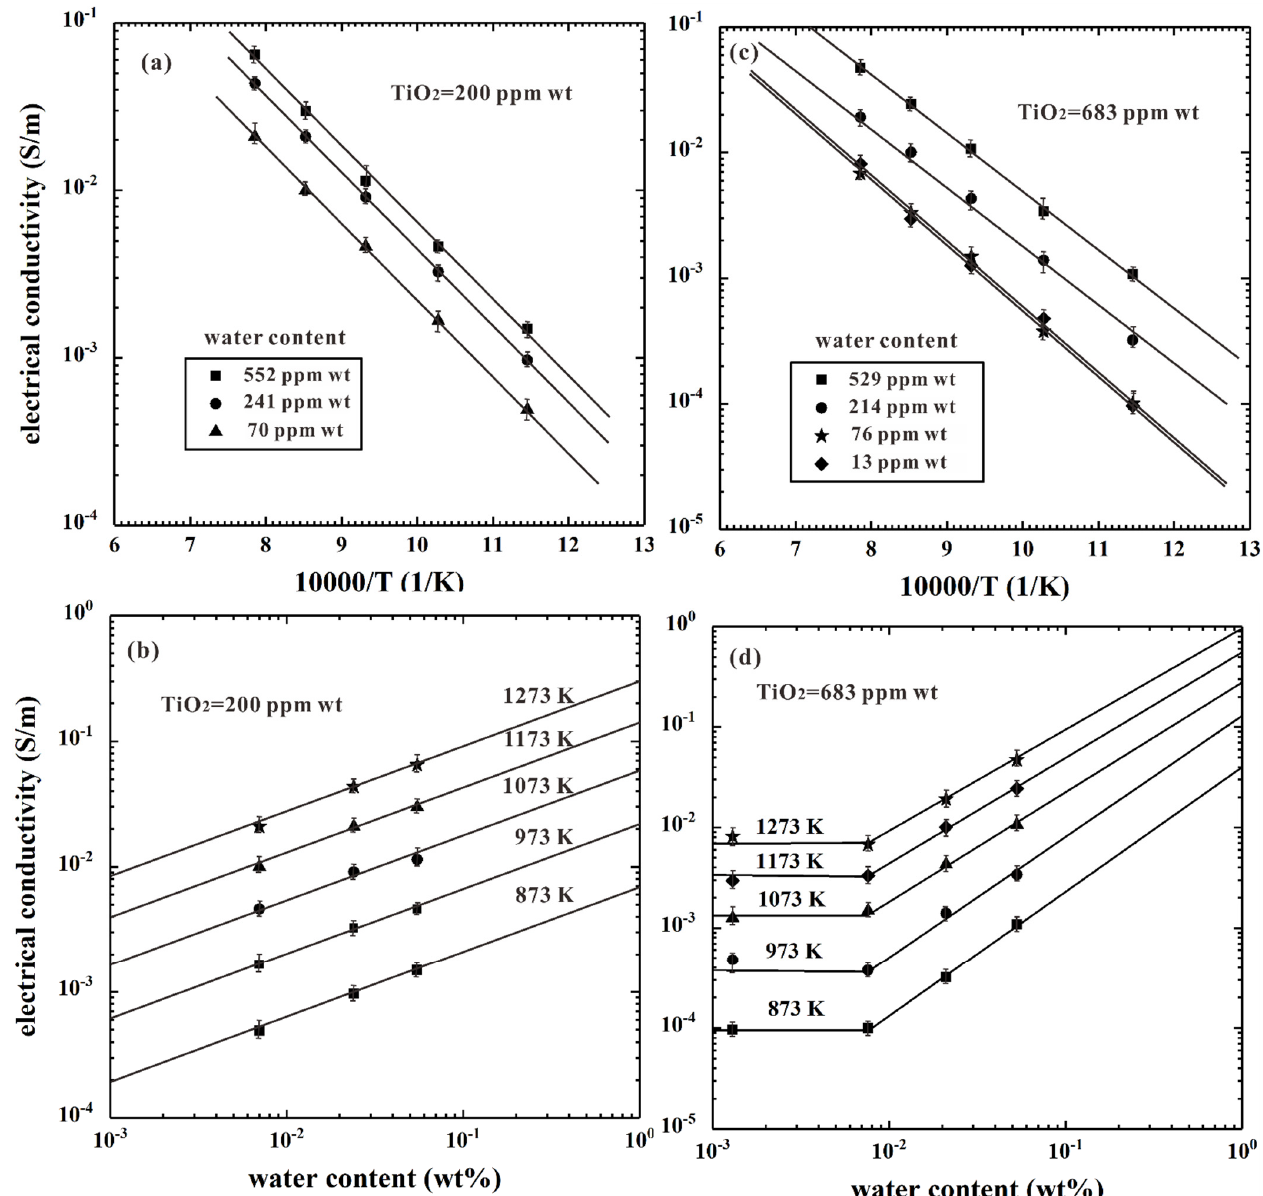
Figure 5. Electrical conductivity of hot-pressed polycrystalline olivine aggregates with different TiO 2 contents under conditions of 4 GPa, 873 ‒ 1273 K, and the Ni ‒ NiO oxygen buffer. Here, ( a ) and ( c ) stand for the dependence of electrical conductivity on the inverse temperature for olivines with its correspondent TiO 2 contents of 200 and 683 ppm wt, respectively; ( b ) and ( d ) stand for the dependence of electrical conductivity on the water content for olivine samples with its correspondent TiO 2 contents of 200 and 683 ppm wt, respectively. The exponential factors between the electrical conductivity for Ti-poor and Ti-rich olivines along with the variation of water content were determined as 0.51 ± 0.18 and 0.98 ± 0.21, respectively (reproduced with permission from the reference of Dai and Karato [9]; published by the American Geophysical Union, 2020).